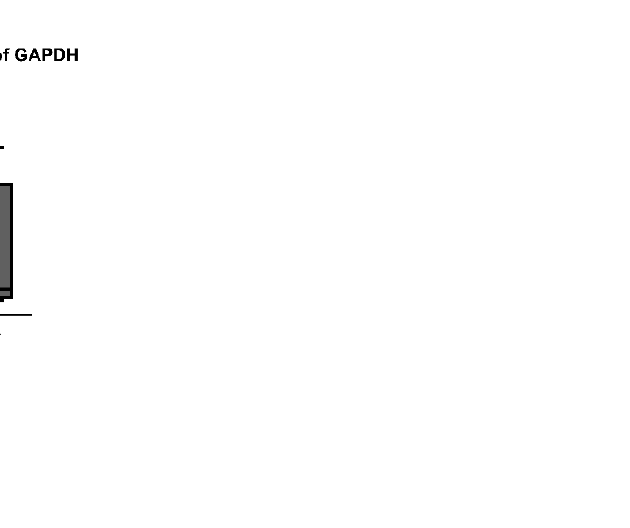
Figure 7. N-terminal calreticulin investigation on a transcriptional level in non-infected DH82 cells and cells persistently infected with CDV-Ond, CDV-Ond neon and CDV-Ond neon-vasostatin , respectively. The number of N-terminal calreticulin mRNA transcripts was significantly higher in DH82 cells persistently infected with CDV-Ond neon-vasostatin compared to non-infected controls and DH82 cells persistently infected with CDV-Ond and CDV-Ond neon . Box plots represent minimum, first quartile, median, third quartile and maximum. Significant differences (Mann–Whitney-U test) are labeled by asterisks: * = p ≤ 0.05.